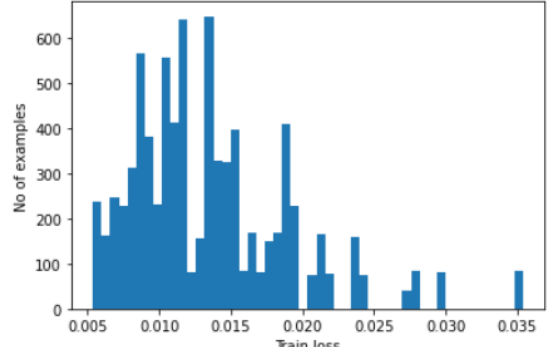
Figure 15. Histogram of train loss.